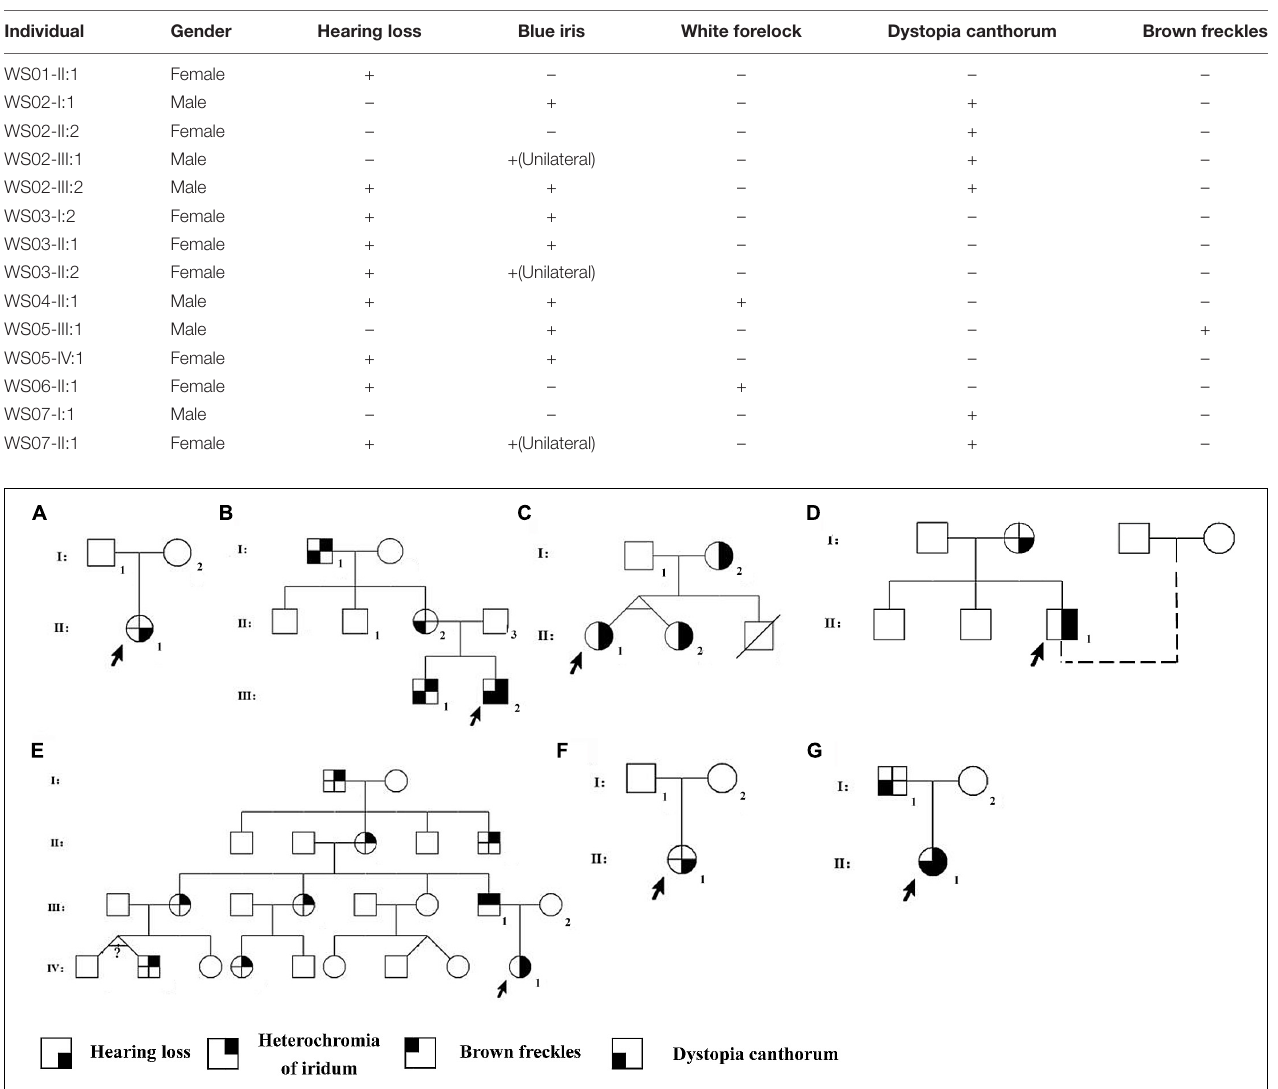
TABLE 1 | Summary of clinical data for patients.